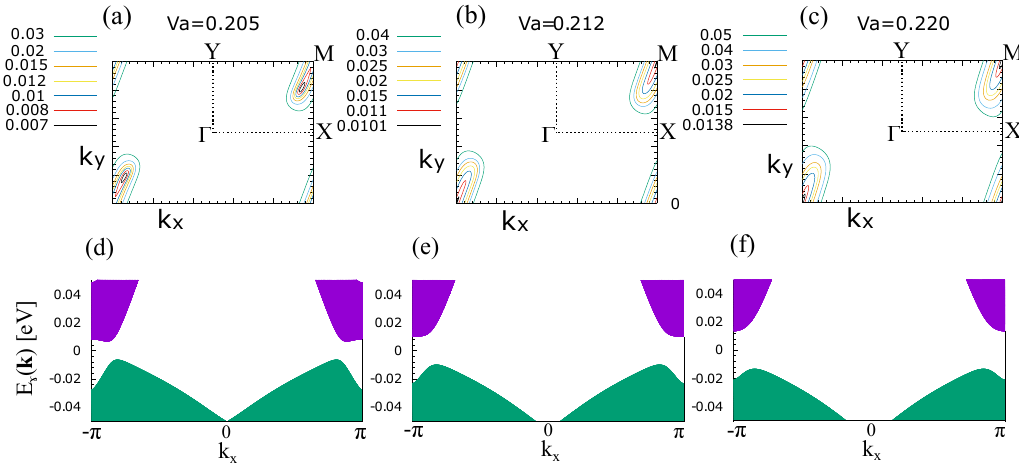
Figure 4. The contour plots of the conduction band for V a = 0.205 ( a ), V a = V c 2 a = 0.212 ( b ), and V a = 0.220 ( c ). The band structures as a function of k x for V a = 0.205 ( d ), V a = V c 2 a = 0.212 ( e ), and V a = 0.220 ( f ), where the CO gaps open between the conduction bands (the purple bands) and the valence bands (the green bands). Tilting of the Dirac cones causes electron-hole asymmetric behavior as the CO gap